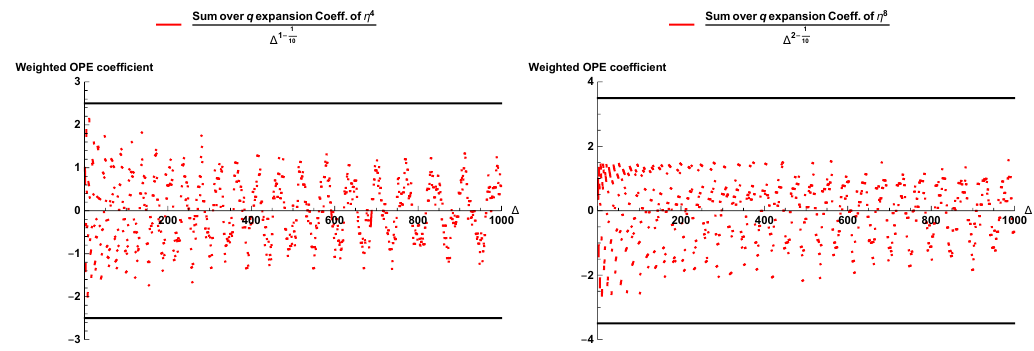
Figure 9 . The ratio of sum of q expansion coe(cid:14)cient upto (cid:1) and (cid:1) (cid:1) O = 2 (cid:0) 1 = 10 as a function of (cid:1) is bounded by an order one number, denoted by the black